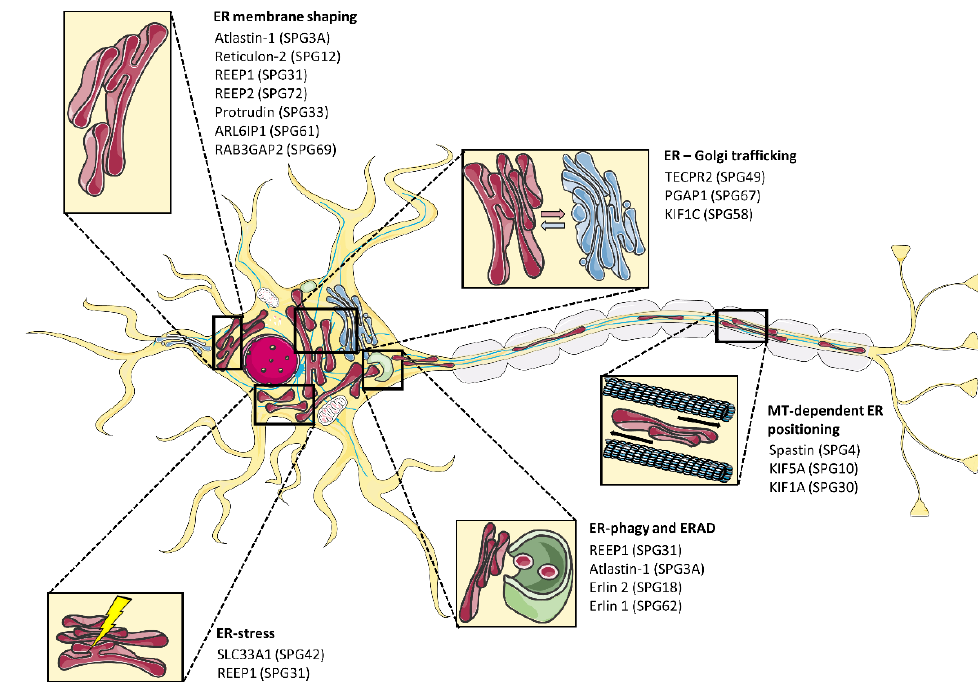
Figure 1. HSP proteins involved in ER-related functions fundamental for neuronal maintenance. Strikingly, if one considers only pure HSP (i.e., those characterized by clinical symp- toms likely arising from degeneration of the corticospinal tract), the vast majority of